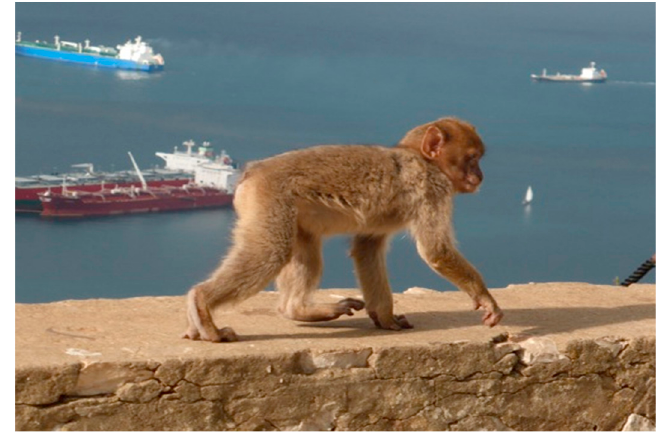
Figure 3. A young specimen of M. sylvanus of the Gibraltar colony (Photo by Cecilia